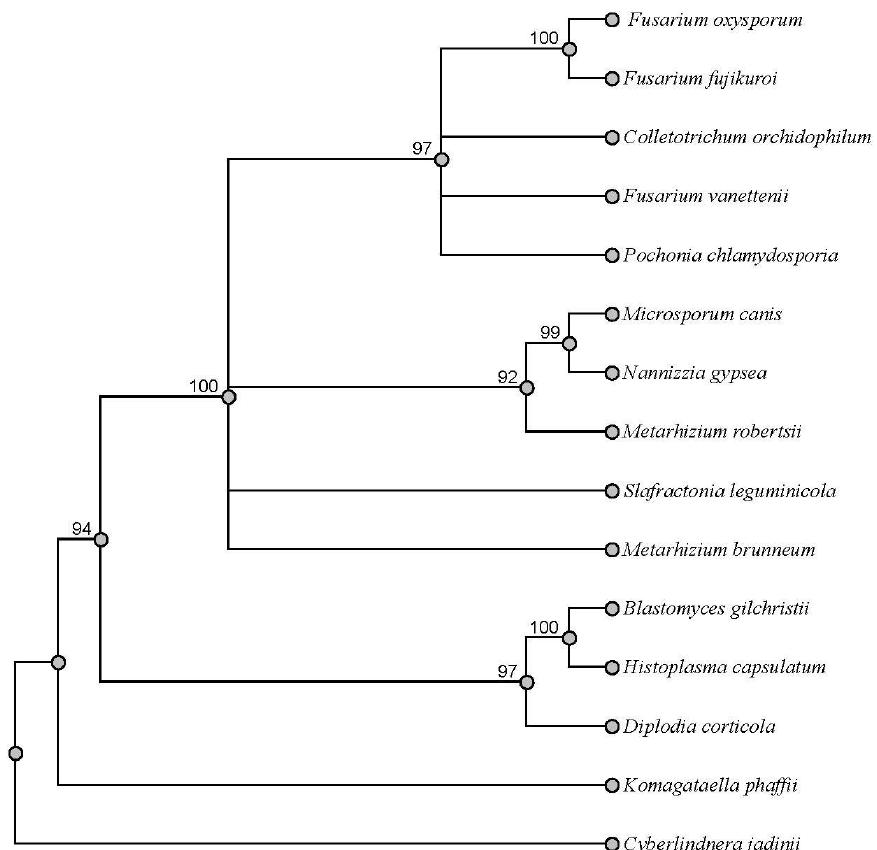
Figure 2. Phylogenetic comparison of SwnT and other related proteins. Protein sequences of each organism were compared with Geneious Prime 2023. The sequences were aligned with MUSCLE alignment and the tree built using PAUP* plugin following the maximum parsimony algorithm with 1000 replications. Cyberlindnera jadinii was used as the outgroup.